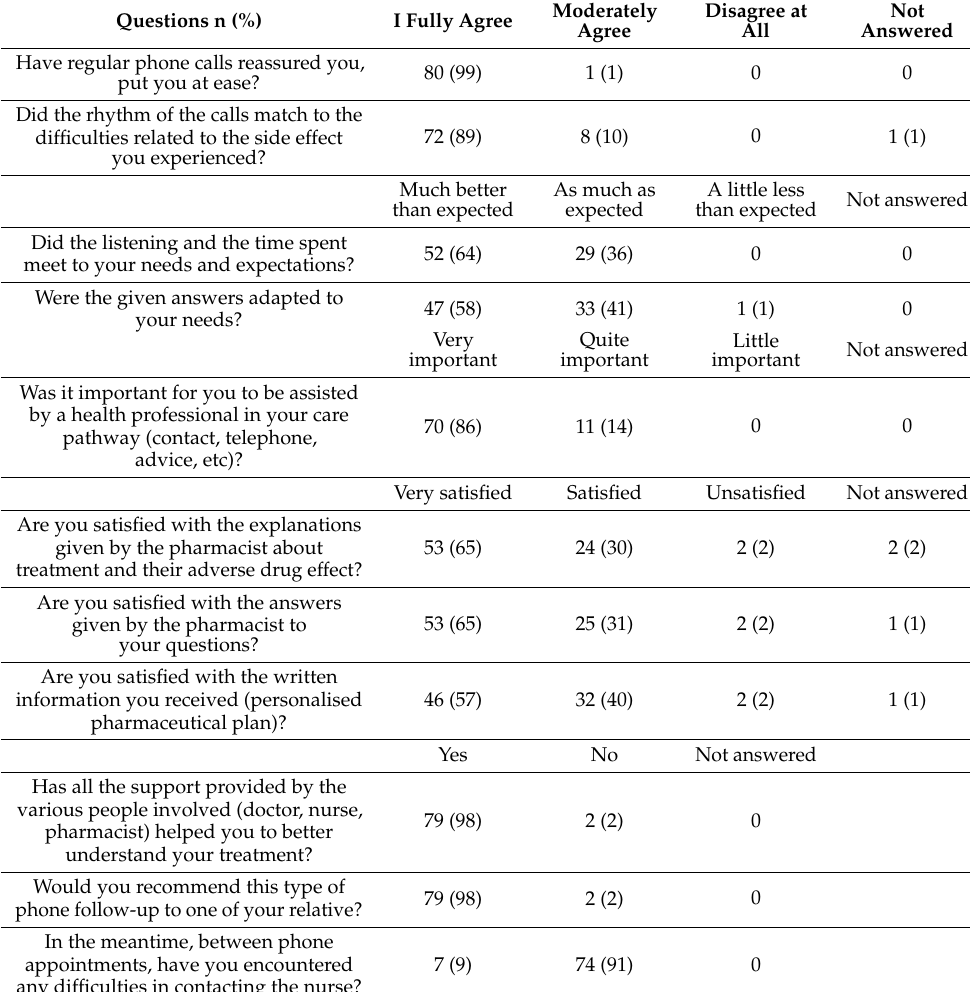
Table 6. Satisfaction questionnaire